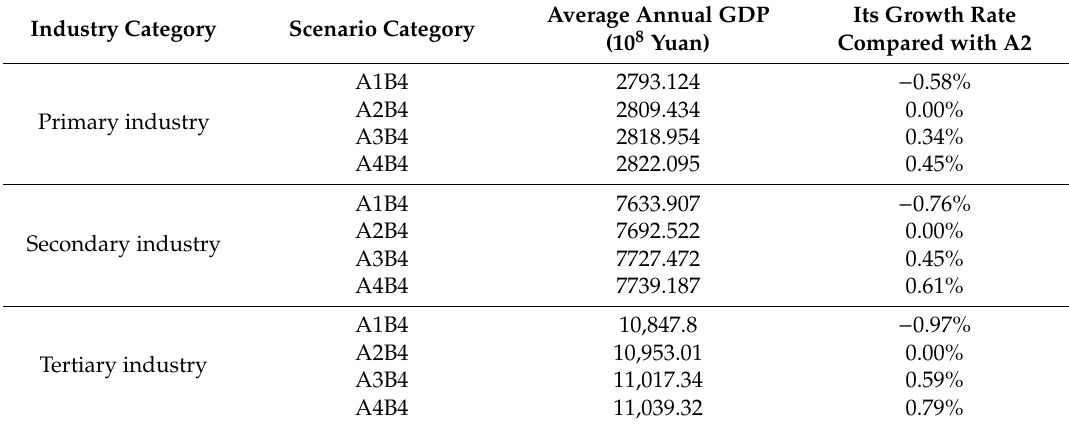
Table 9. Average annual output value of various industries and its growth rate compared with A2 under